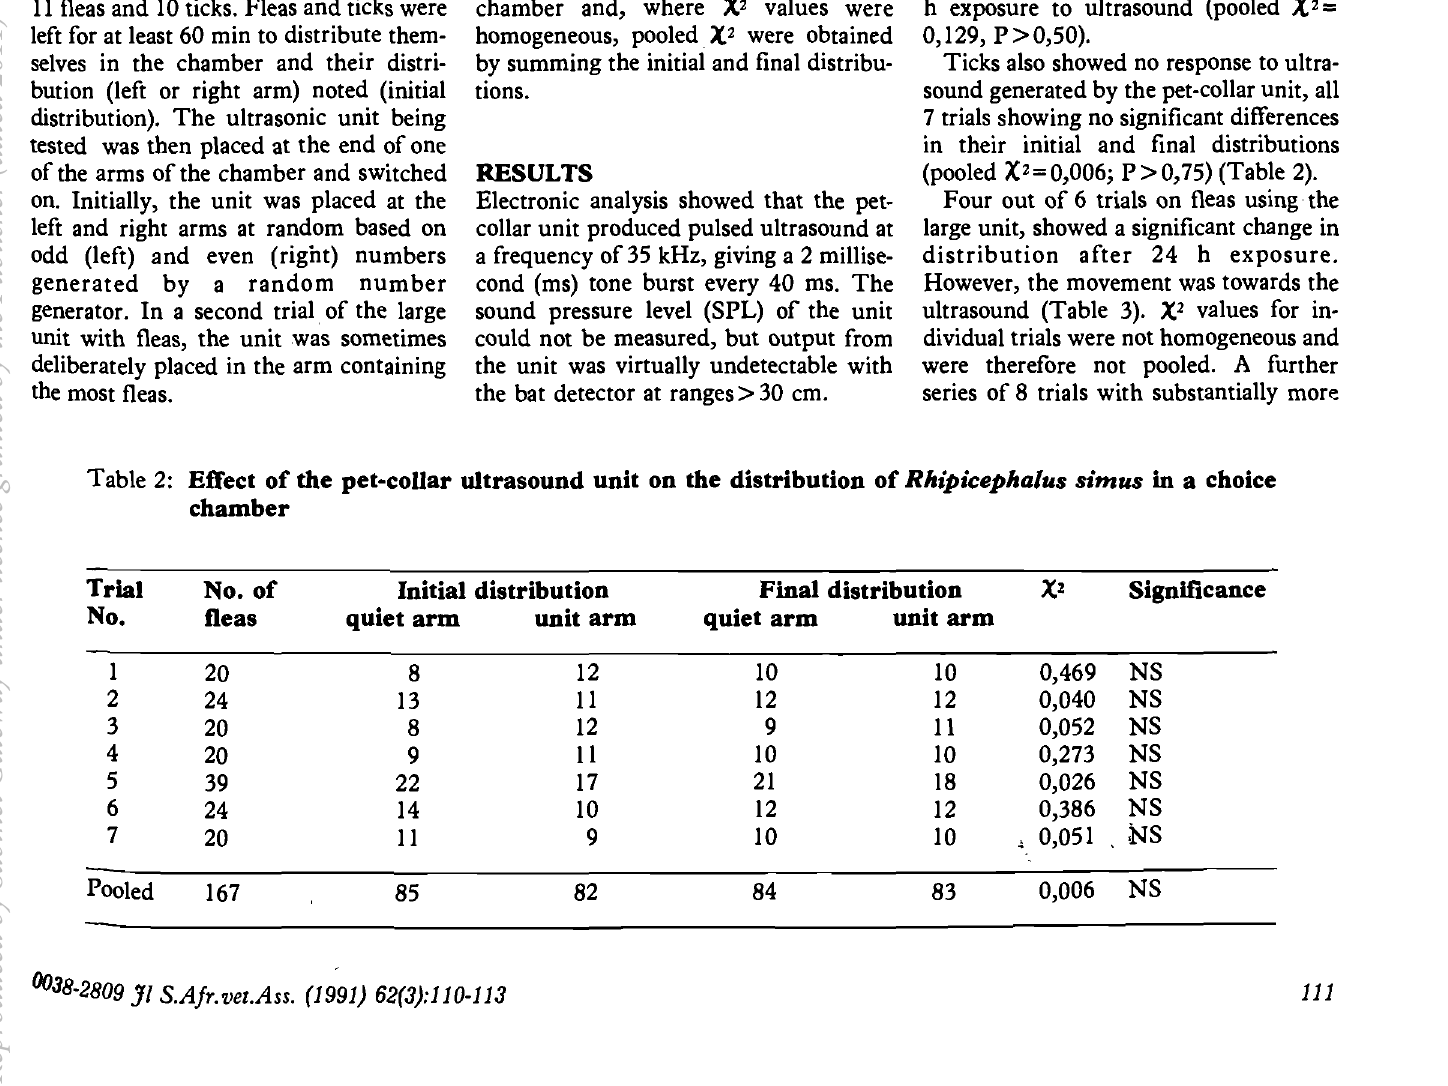
Table 2: Effect of the pet-collar ultrasound unit on the distribution of Rhipicephalus simus in a choice